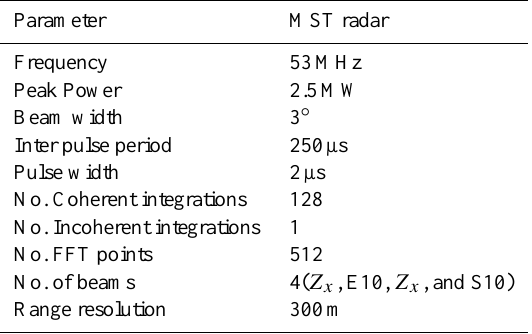
Table 1. Important specifications and parameters of IMSTR used in the present